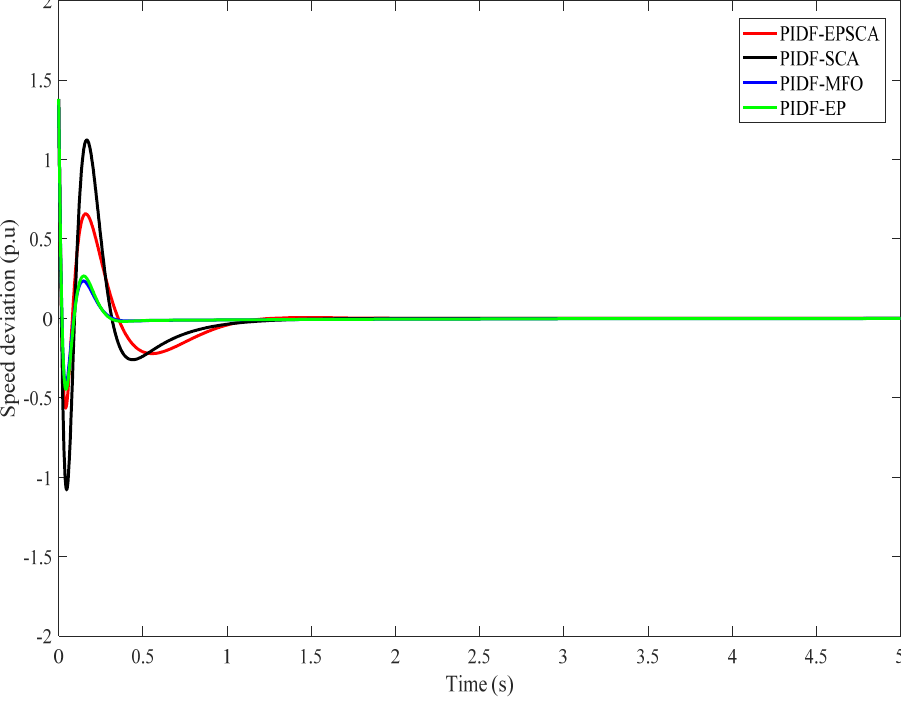
Figure 22. Speed deviation response of the TCSC-PIDF controller using PIDF-EPSCA, PIDF-SCA, PIDF-MFO, and PIDF-EP techniques for Scenario A-3.